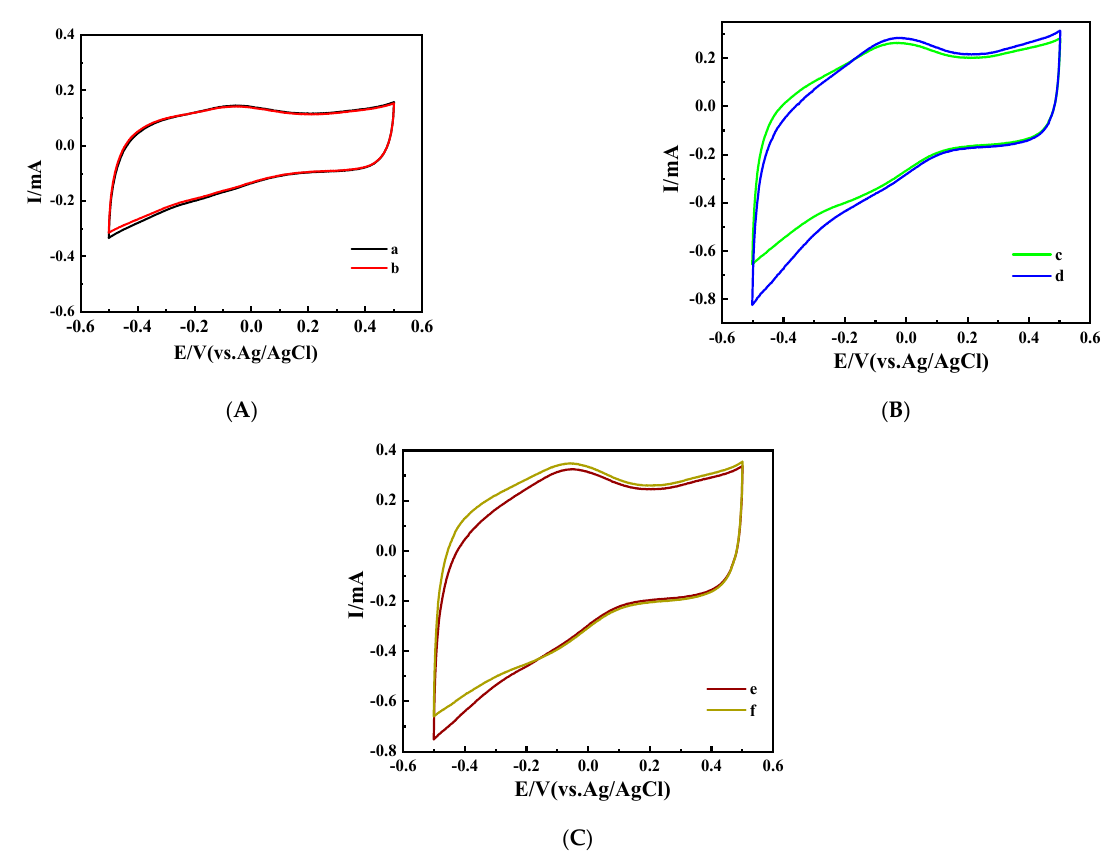
trode surface. Figure 6. CVs (50 mV · s − 1 ) of Nafion/OMC-COOH (a), Nafion/GOx/OMC-COOH (b), and Nafion/ Figure 6. CVs (50 mV·s − 1 ) of Nafion/OMC-COOH (a), Nafion/GOx/OMC-COOH (b), and Nafi- GOx-NH 2 /OMC-COOH (c) in air-saturated PBS (0.1 M pH 7.4) without glucose. on/GOx-NH 2 /OMC-COOH (c) in air-saturated PBS (0.1 M pH 7.4) without glucose.